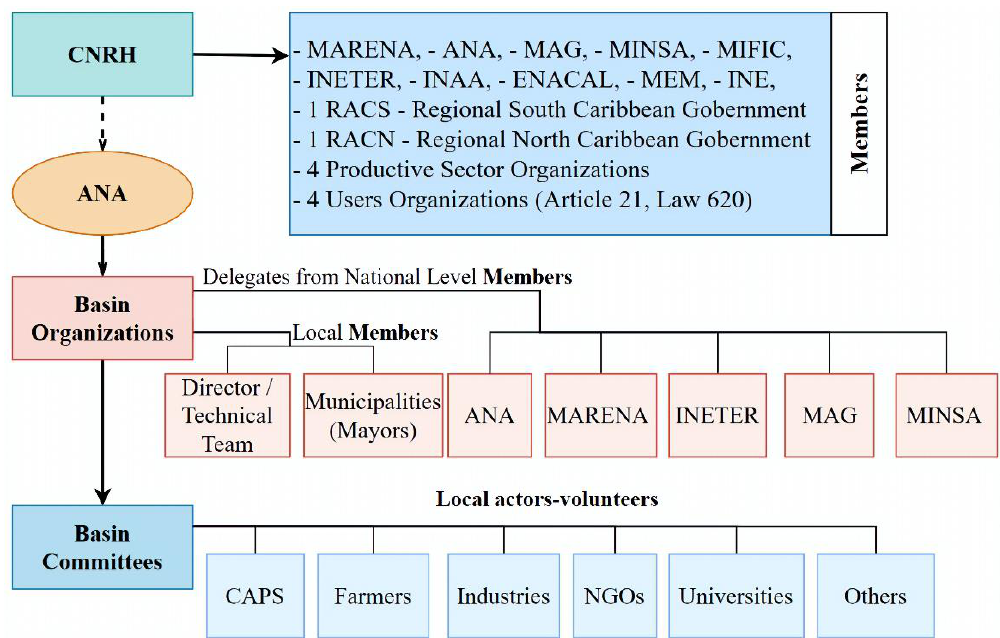
Figure 3. Nicaraguan water system. CNRH: National Water Resources Commission; MARENA: Environmental and Natural Resources Ministry; MAG: Agricultural Ministry; MINSA: Health Ministry; MIFIC: Ministry of Industry, Development, and Commerce; INETER: Nicaraguan Institute of Territorial Studies; INAA: Nicaraguan Institute for Water and Sanitation; ENACAL: National Water Supply and Sewage Company; MEM: Energy and Mines Ministry; INE: Nicaraguan Institute of Energy; CAPS: water and sanitation committees.